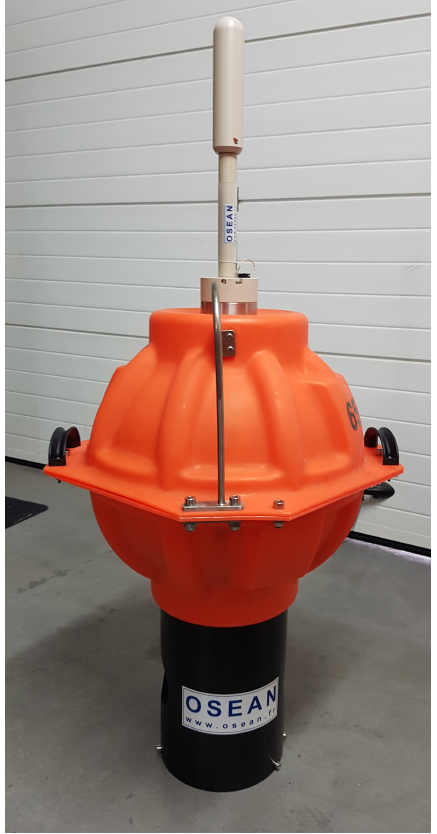
Figure 6. Bombyx2—Project Interreg Maritime GIAS (whale anti-collision sonobuoy), here